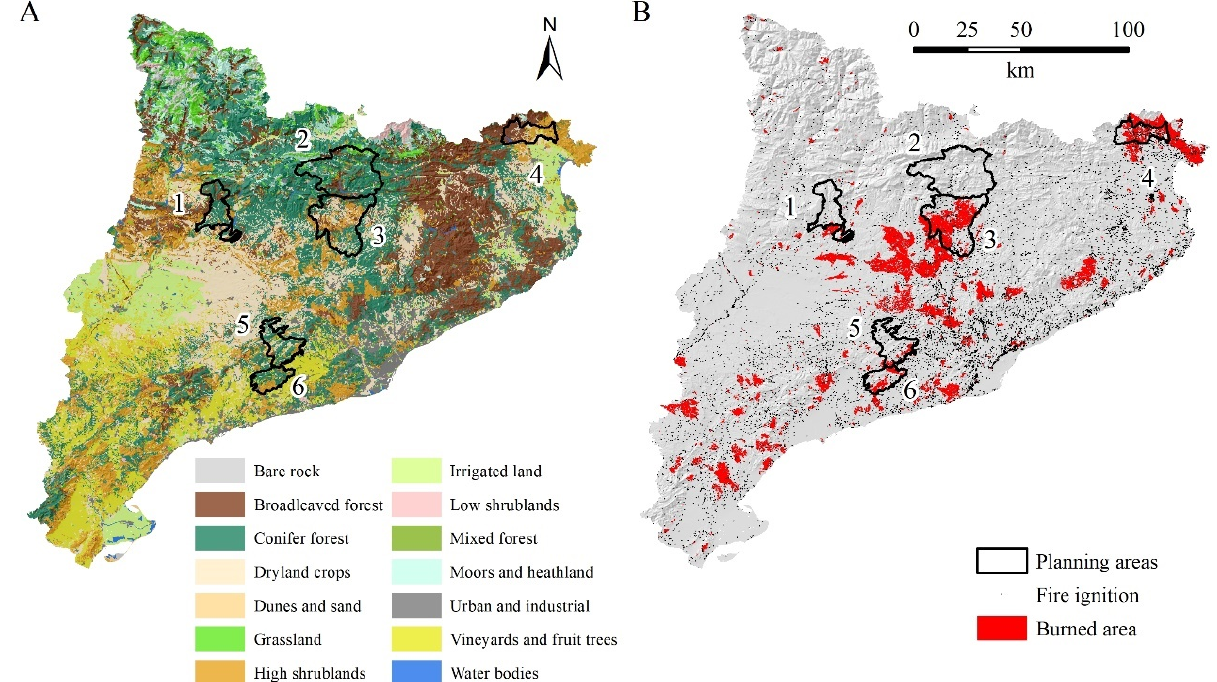
Figure 1. Land cover ( A ) and historic wildfire activity ( B ) in Catalonia (northeastern Spain). In total, the six planning areas encompass about 1000 km 2 . The numbers are the planning area codes (see Appendix A).